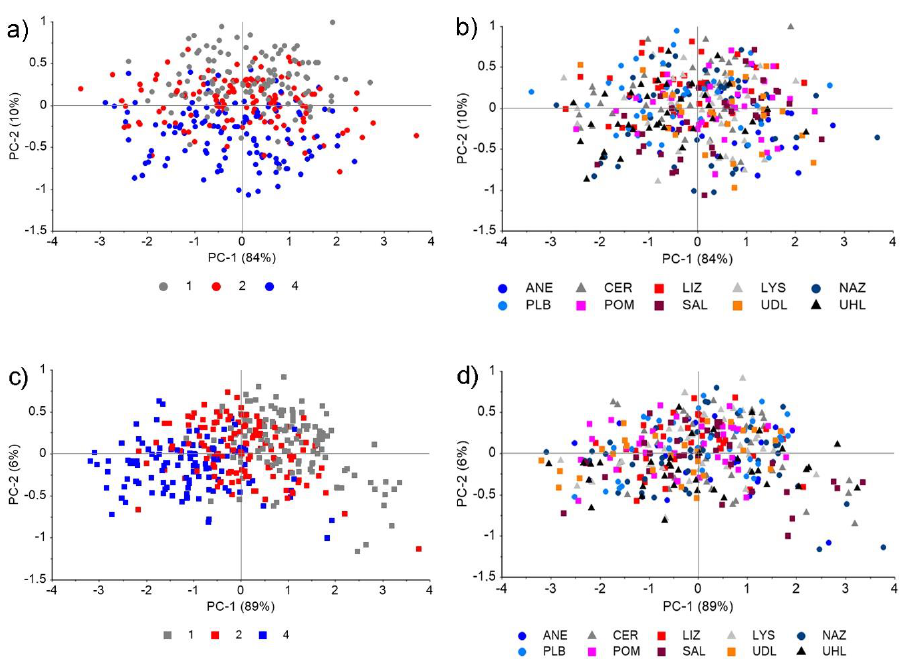
Figure 6. Score plots for principal component analysis (PCA) applied on needle optical properties. Score plot based on reflectance (DHRF) showing separation according to ( a ) needle age classes and ( b ) catchments; score plot based on transmittance (DHTF) showing separation according to ( c ) needle age classes and ( d ) catchments.